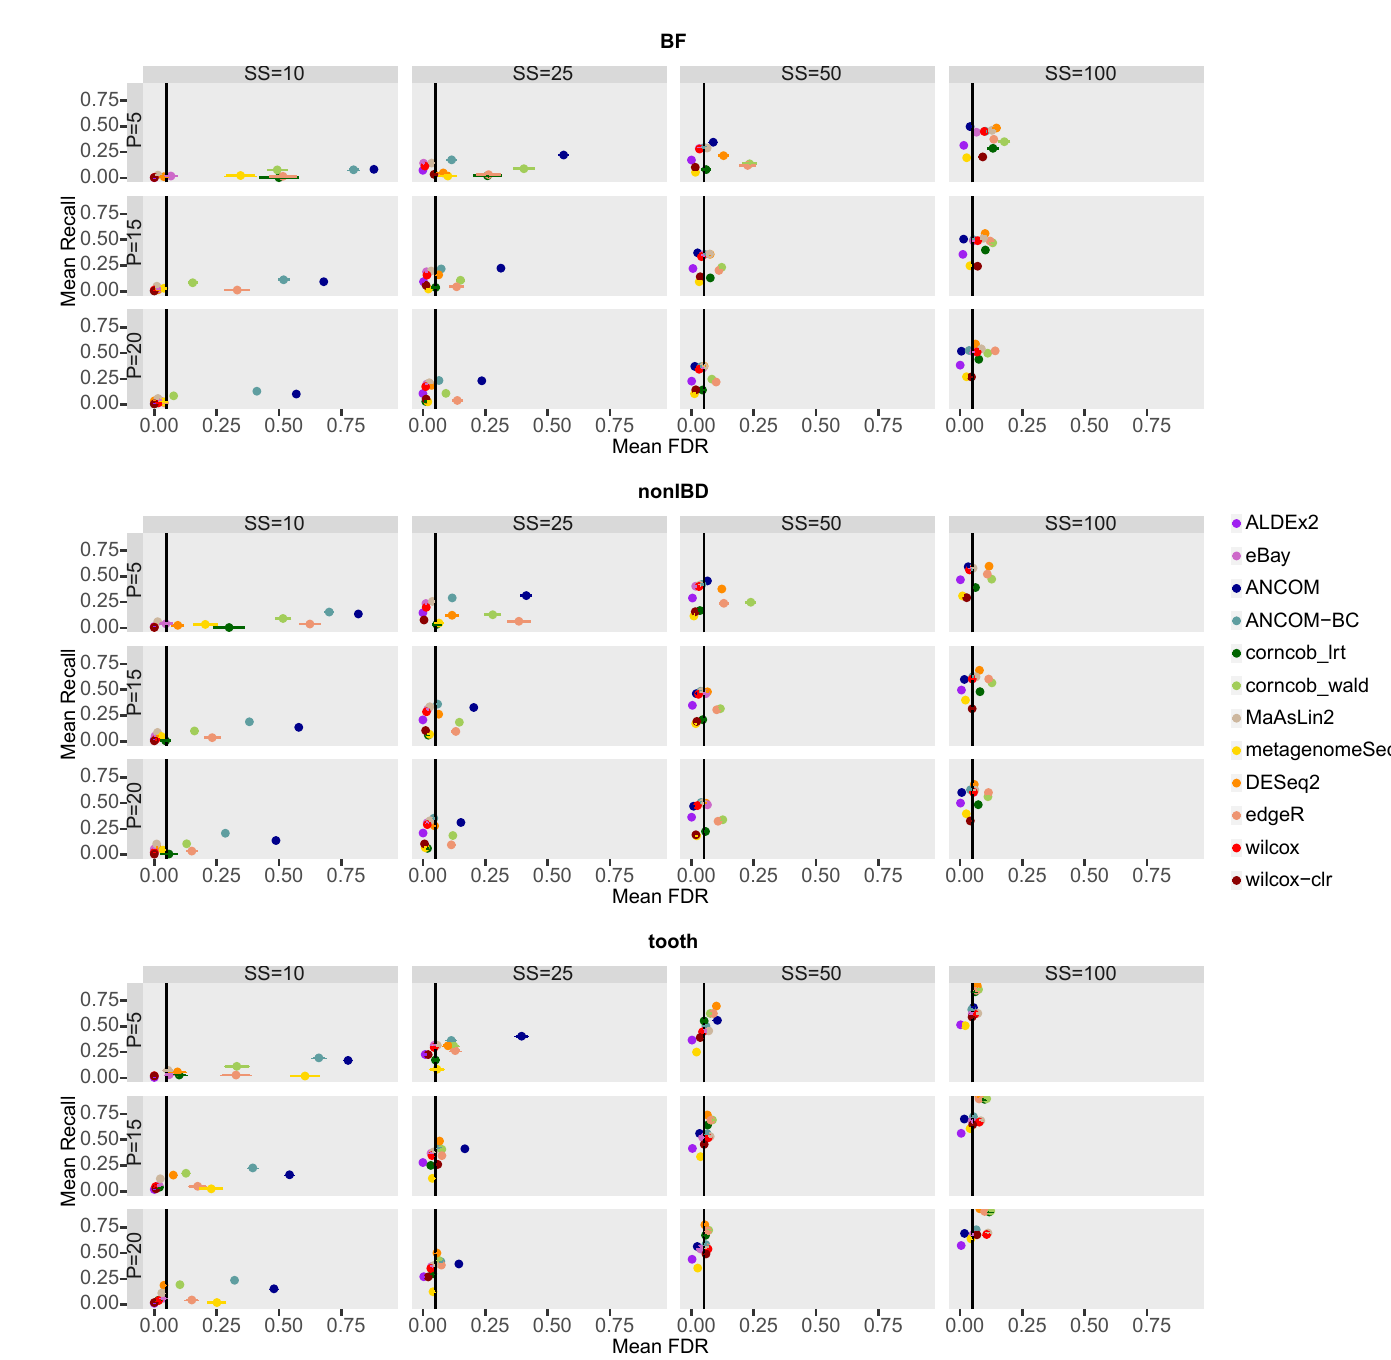
Fig 5. Mean Recall (on y axis) and FDR (on x axis) of each differential abundance method for each dataset considered in the comparison in the main scenario with simulated DA features. In each set of boxes corresponding to the dataset, different percentages (P) of simulated DA features are on rows, while different sample size (SS) values are on columns. The recall values are averaged over the 50 simulations and the bars show the standard